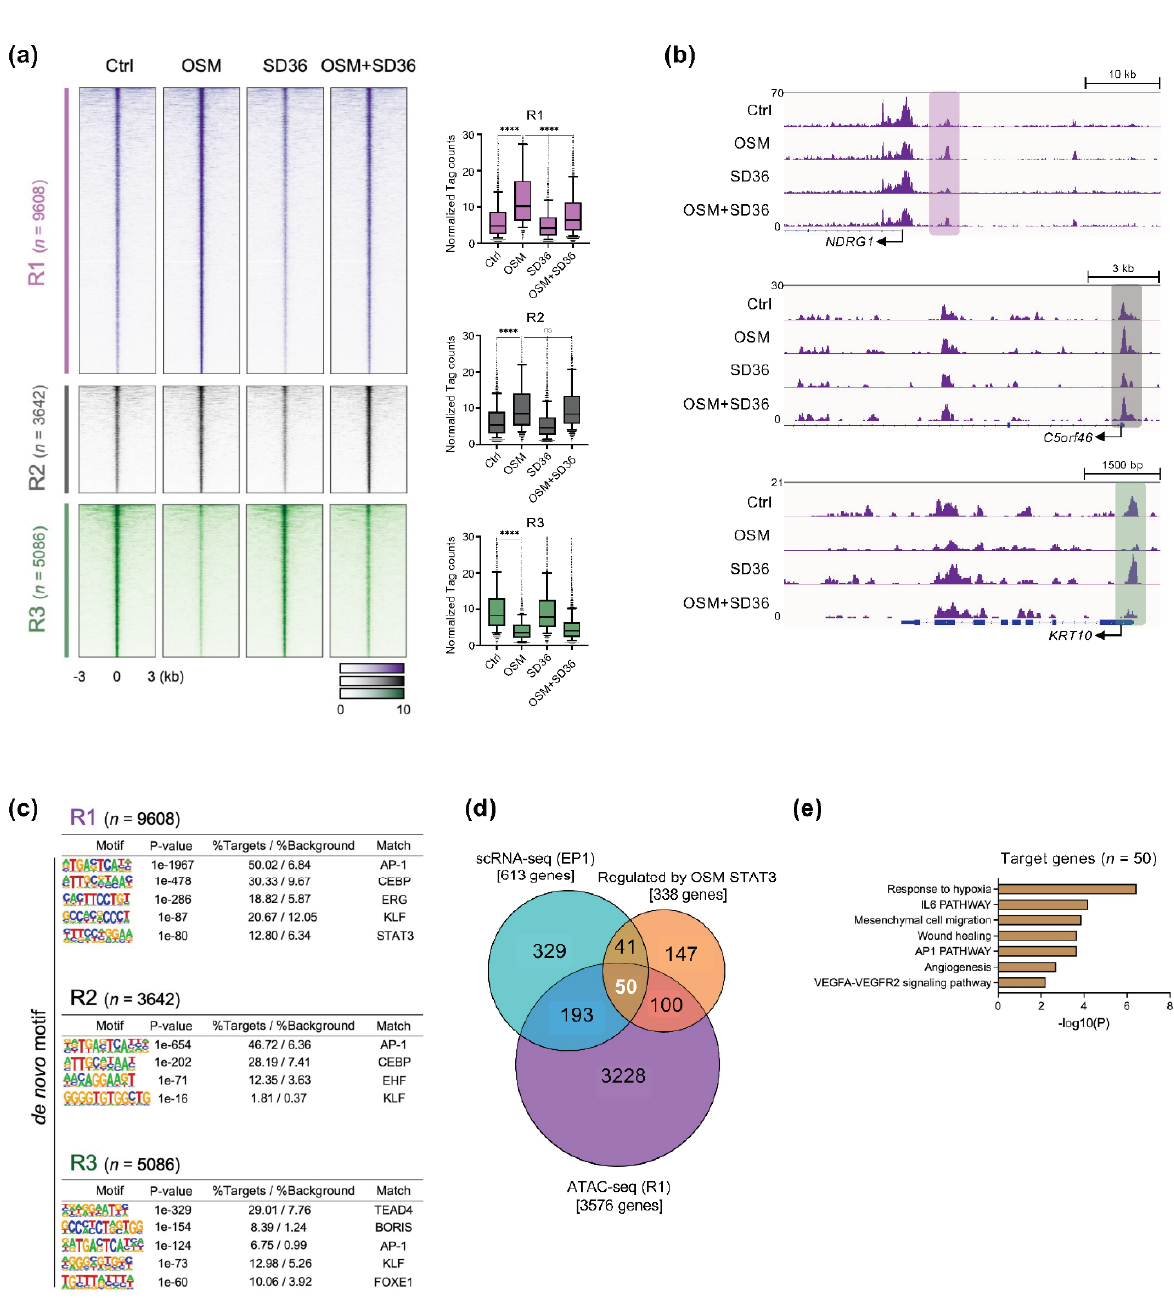
Figure 5. Epigenomic landscape of OSM-STAT3-activated cervical cancer cells. ( a ) Left, heatmap of open chromatin regions defined by ATAC-seq in the three clusters identified in Figure 3C. Right, the bar plot shows the normalized tag counts in each cluster; **** p < 0.0001; Ordinary one-way ANOVA. ( b ) Representative IGV genome browser tracks displaying normalized tag density and RNA expression level profiles in NDRG1 , C5orf46, and KRT10 under four conditions. ( c ) The